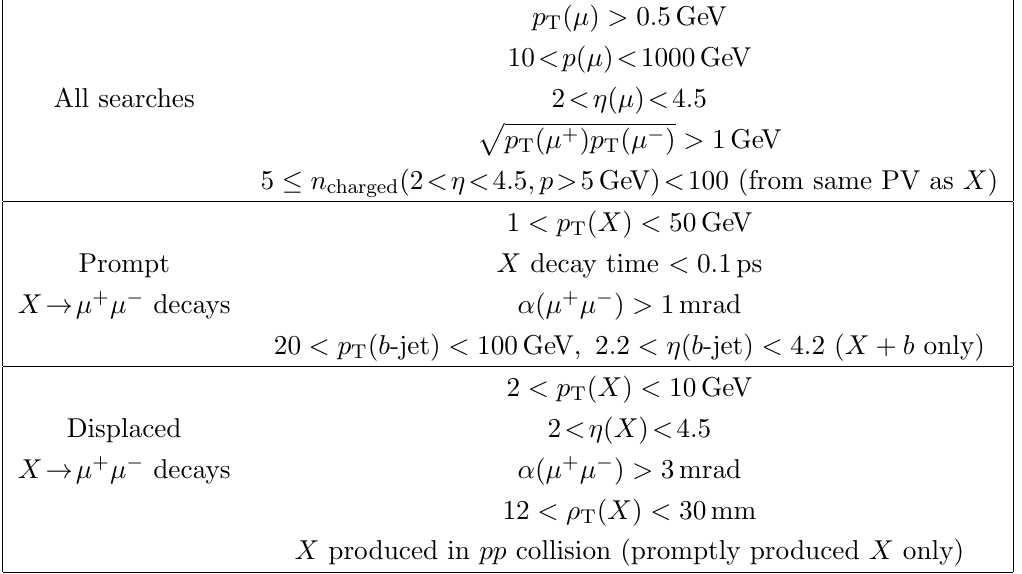
(cid:22) + (cid:22) (cid:0) !